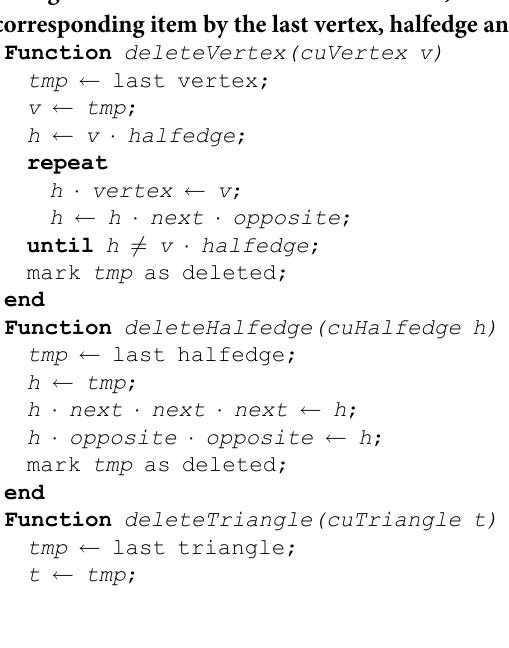
Algorithm 2: The functions deleteVertex, deleteHalfedge and deleteTriangle replace the corresponding item by the last vertex, halfedge and triangle in the list, respectively